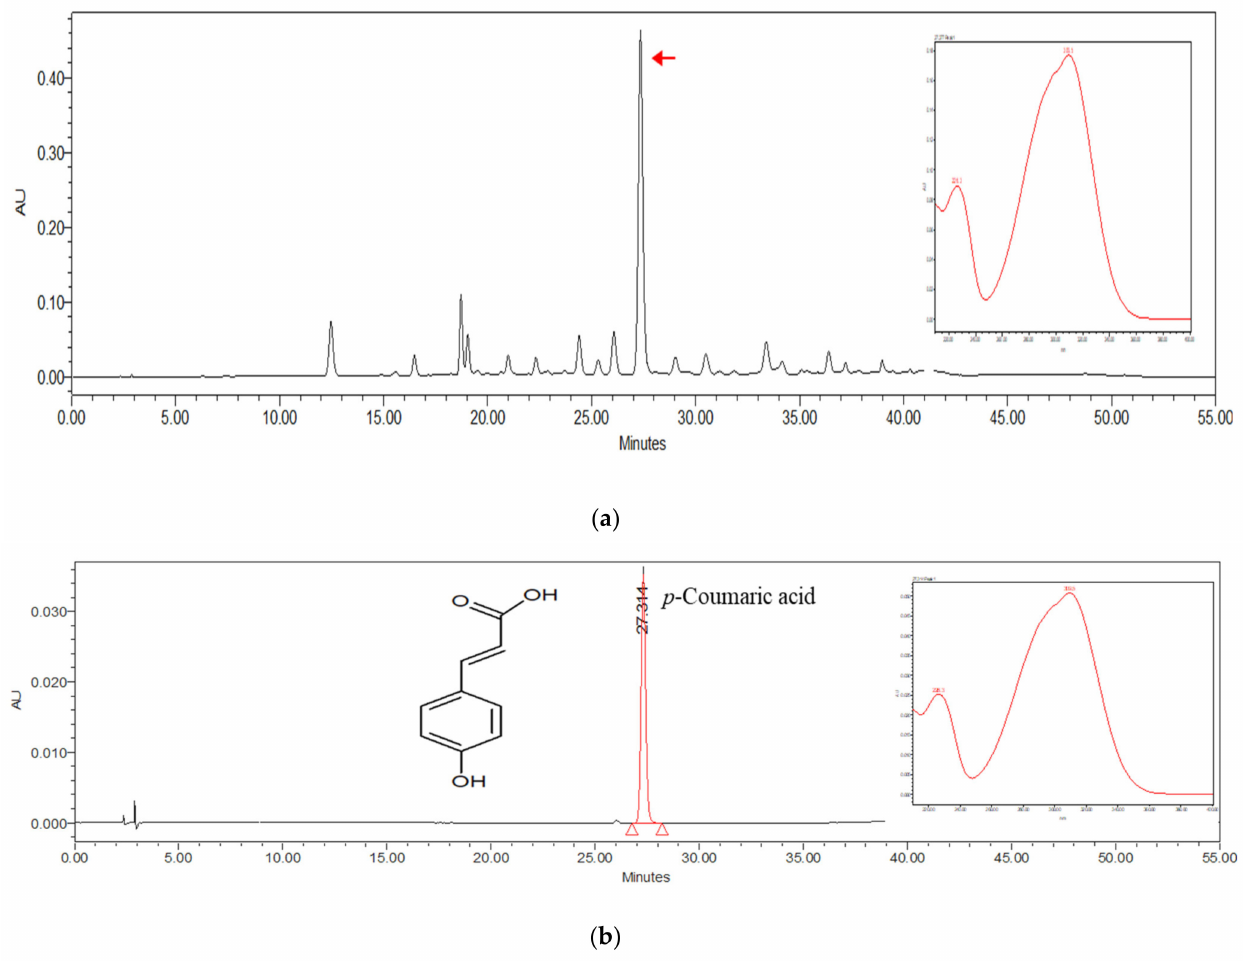
Figure 1. High-performance liquid chromatography chromatogram for ( a ) standardization of NET-D1602 and ( b ) chemical structure of p -coumaric